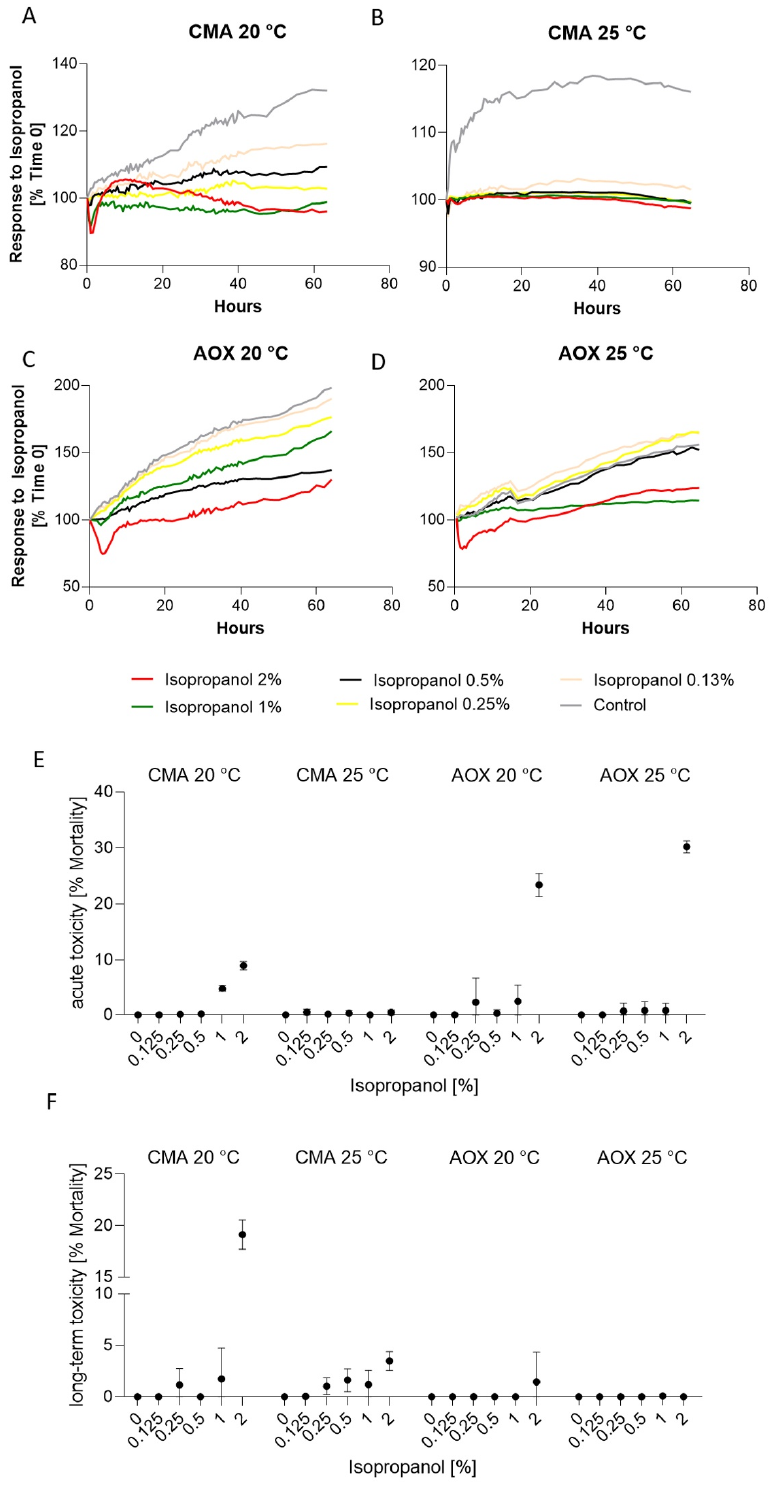
Figure 4. Response of CMAfin1 ( C. maraena ) and AOXlar7y ( A. oxyrinchus ) cells on isopropanol addition under 20 and 25 ◦ C cultivation. ( A – D ) Visualization of growth curves over time (% con- fluence) at different isopropanol concentrations (2%—red, 1%—green, 0.5%—black, 0.25%—yellow, 0.125%—beige, control; 0%—grey). ( E ) Calculated acute toxicity (% mortality compared to the initial confluence value) and ( F ) long-term toxicity (% mortality compared to the initial confluence value) from 4 replicates per experimental